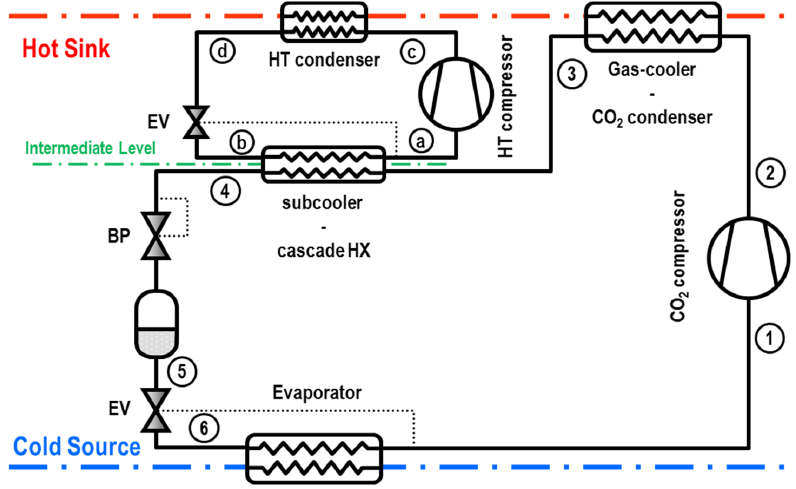
Figure 1. Schematic representation of cascade and CO 2 with mechanical subcooling.